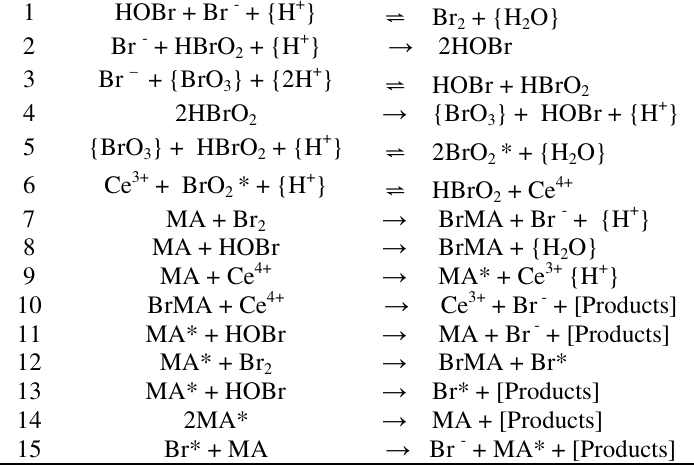
Table 1. Eleven variable GRF chaotic